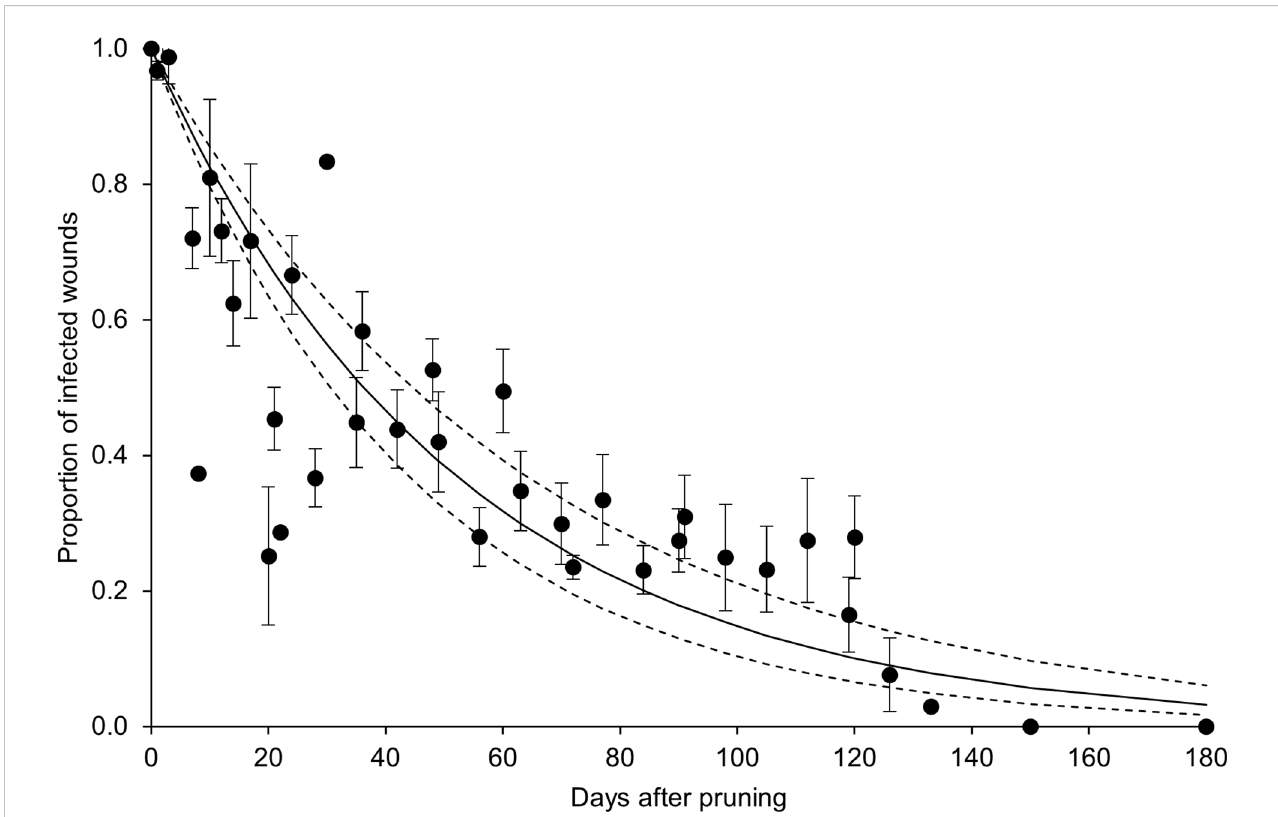
FIGURE 4 Proportion of pruning wounds that became infected as a function of DAP (number of days after pruning when the wounds were inoculated with fungi associated with grape trunk diseases [GTDs]) for the whole dataset shown in Table 1. Dots are averages of the observed values for each day, and whiskers represent the standard error. The full line shows the fi t of the observed data with equation [1] (see text and Table 2), and the dashed lines show the upper and lower intervals of the distribution (i.e., a ± standard